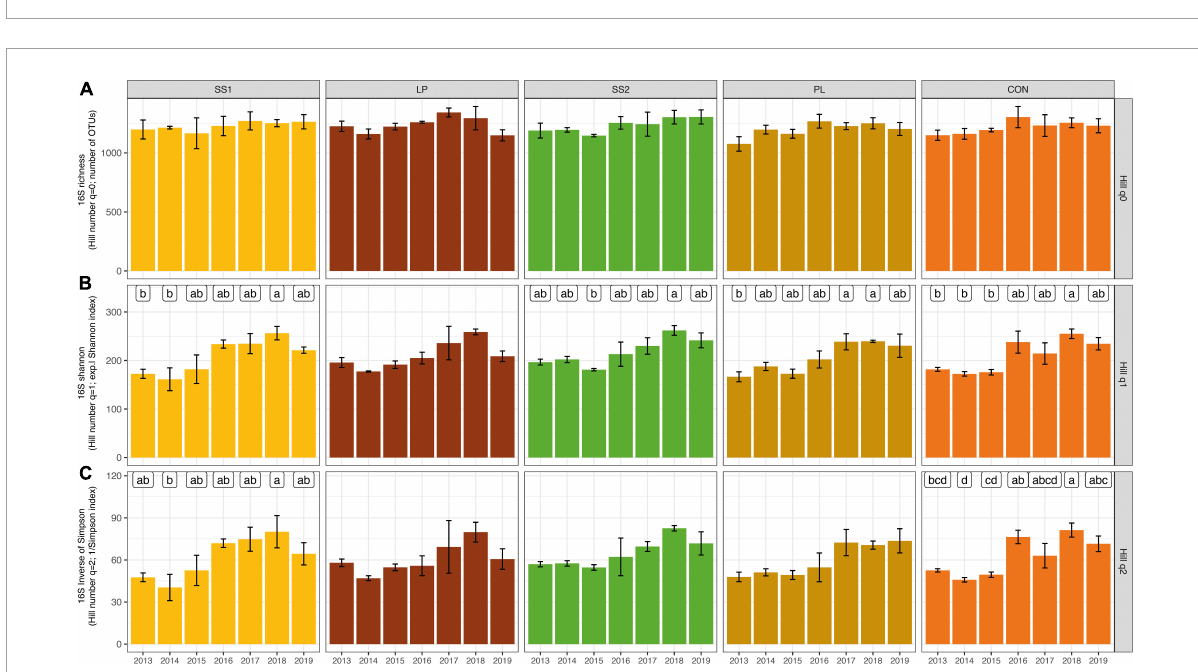
FIGURE2 Dynamic of molecular microbial biomass in soil from La Mare (Reunion Island) fertilized or not (inorganic fertilizer control, CON) with four different organic materials (SS1 and SS2, sewage sludge inputs; LP, liquid pig manure; PL, poultry litter). Different letters indicate significant differences based on Kruskal-Wallis test with Bonferroni correction ( P < 0.05).